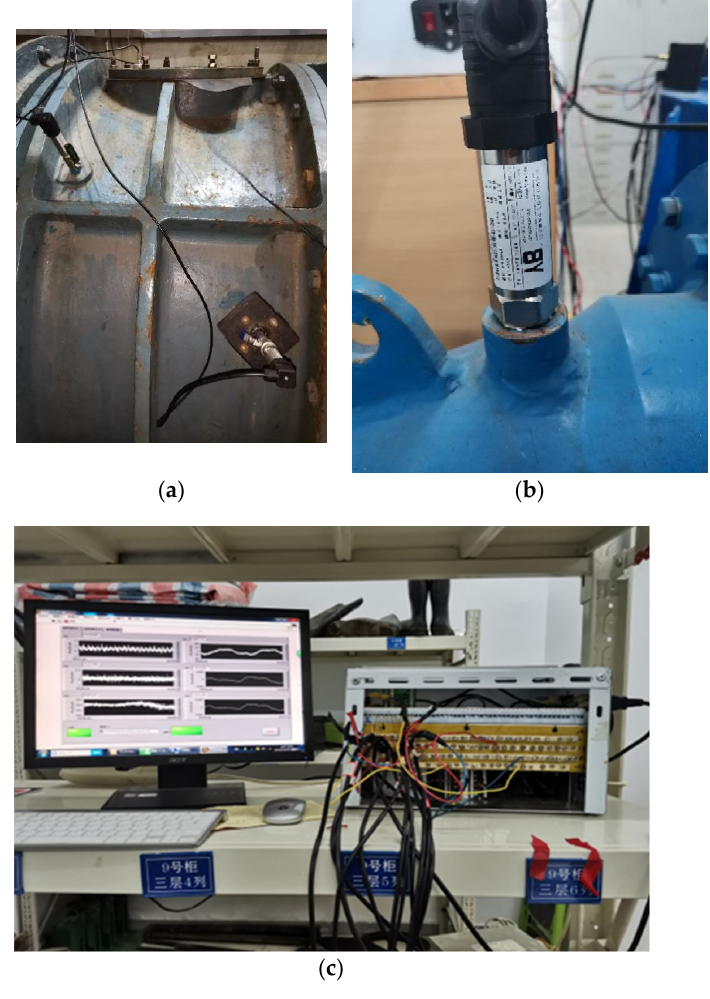
Figure 7. Experimental setup. ( a ) Monitoring point layout. ( b ) Pressure sensor. ( c ) Measuring in ‐ strument.